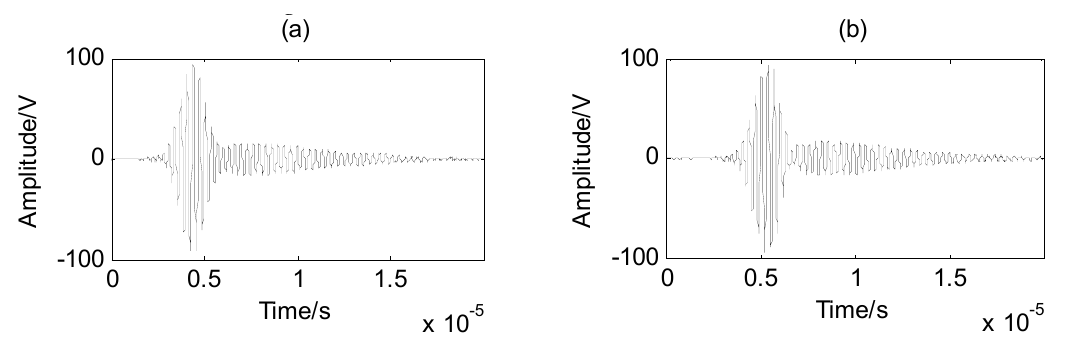
Figure 2. Lamb waves incident angle dispersion curve.